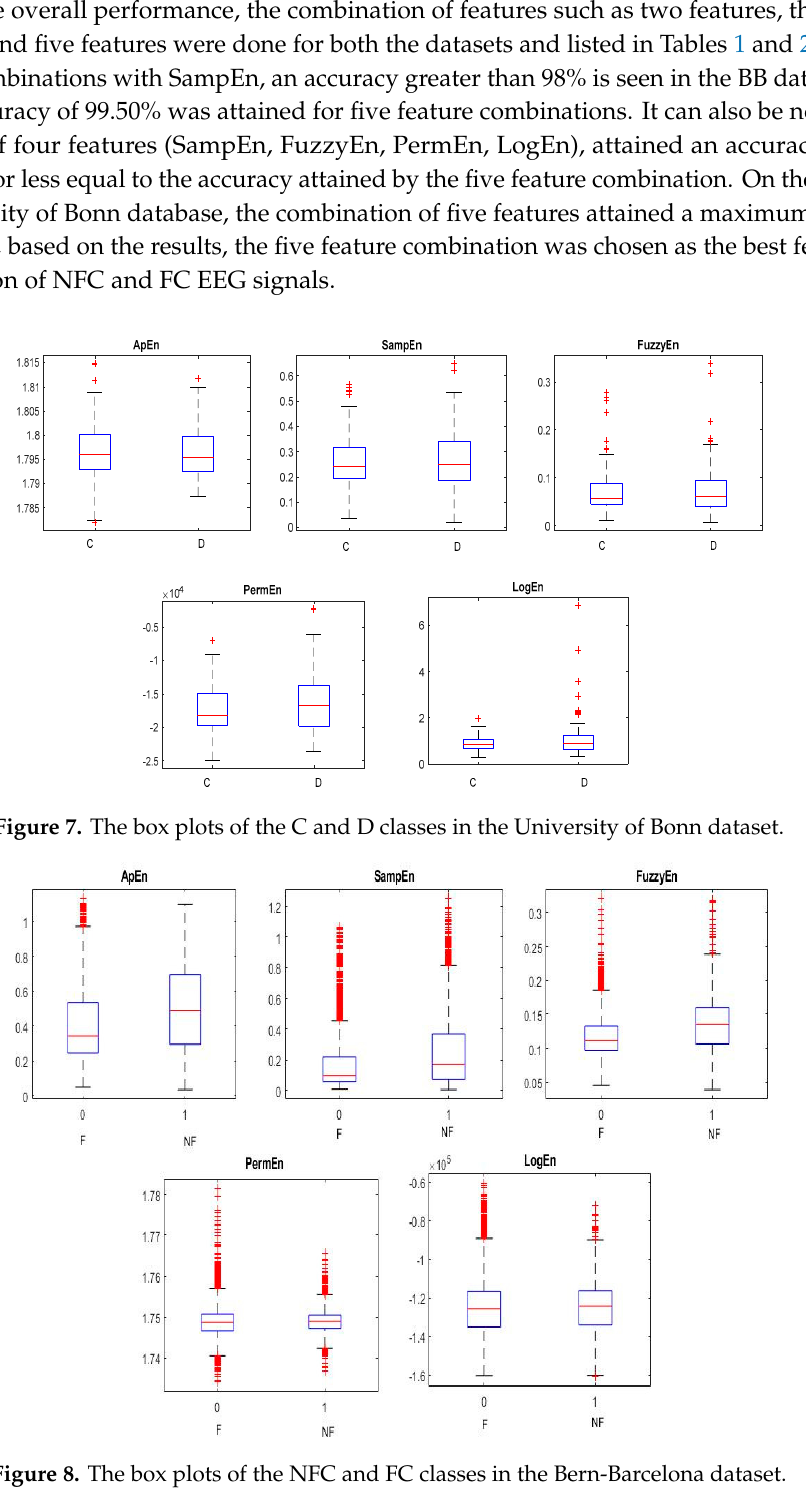
Figure 8. The box plots of the NFC and FC classes in the Bern-Barcelona dataset.